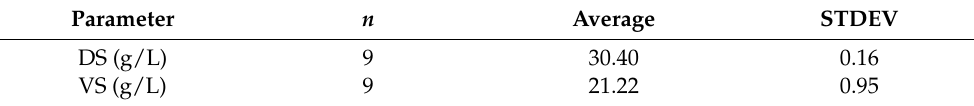
Table 3. Quality of sludge mixture with inoculum before the digestion process.